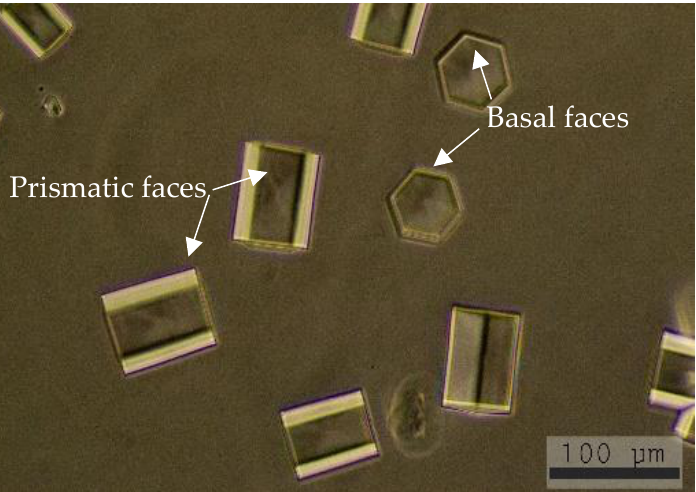
Figure 1. Prismatic (rectangle) and basal (hexagon) crystal faces of the HheG wildtype crystals. Reprinted with permission from [29]. Copyright (2018) American Chemical Society.